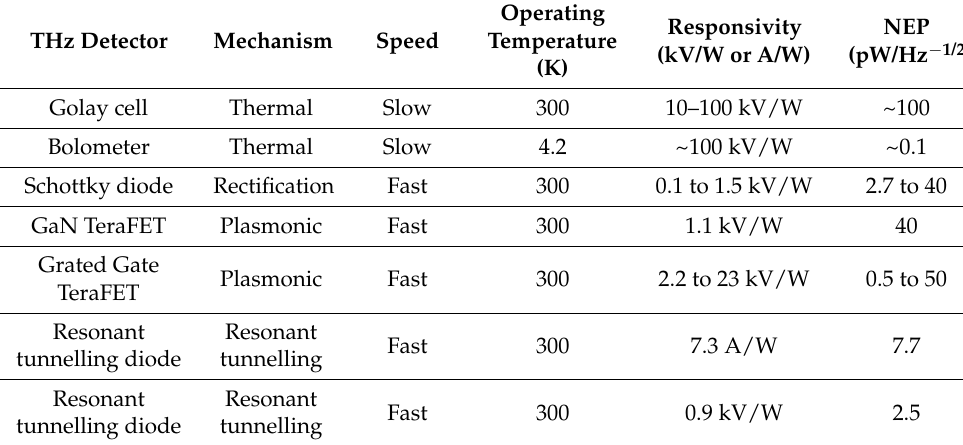
Table 2. Performance of THz detection devices (data from